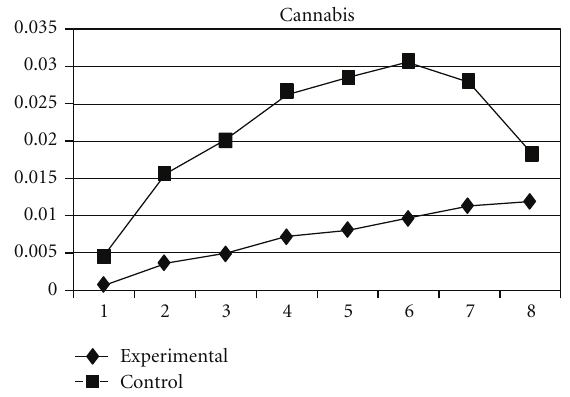
Figure 8: Growth trajectories of the experimental group (all partic- ipants) and control group using the composite score of legal drug use as the outcome indicator.